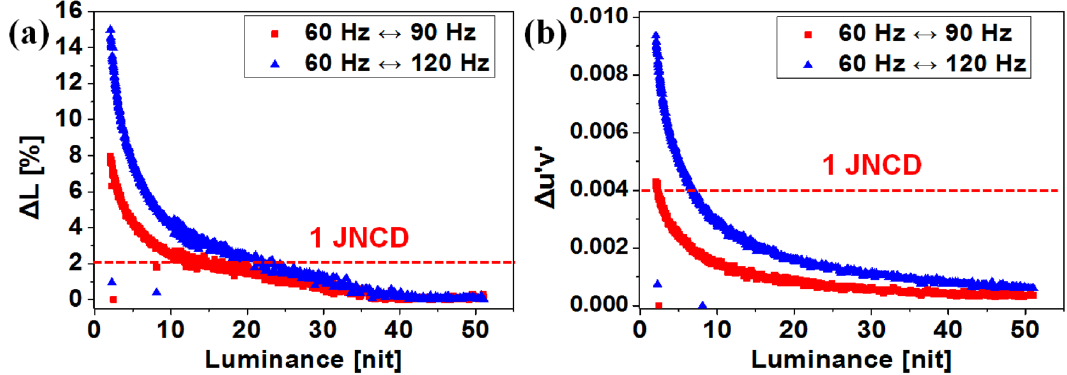
Figure 2. Differences in ( a ) luminance and ( b ) color under a frequency change from 60 to 90 Hz and 60 Hz to 120 Hz without V INI compensation.